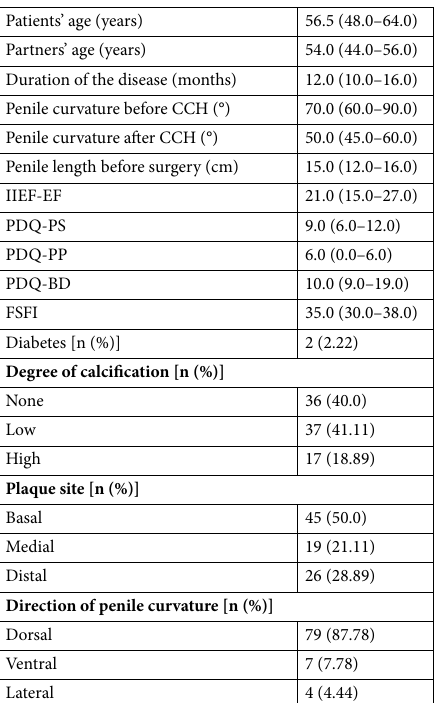
Group 1 Group 2 Group 3 p-value* Penile length (cm), median (IQR) + 2.0 (1.0, 2.0) Table 2. Median changes of clinical variables from baseline to final follow-up in the three groups. Group 1 grafting procedure + penile prosthesis implant (PPI), Group 2 grafting procedure only, Group 3 Nesbit procedure, IQR interquartile range, IIEF international index of erectile function, PDQ Peyronie’s disease questionnaire, FSFI female sexual function index. *Kruskal–Wallis test.